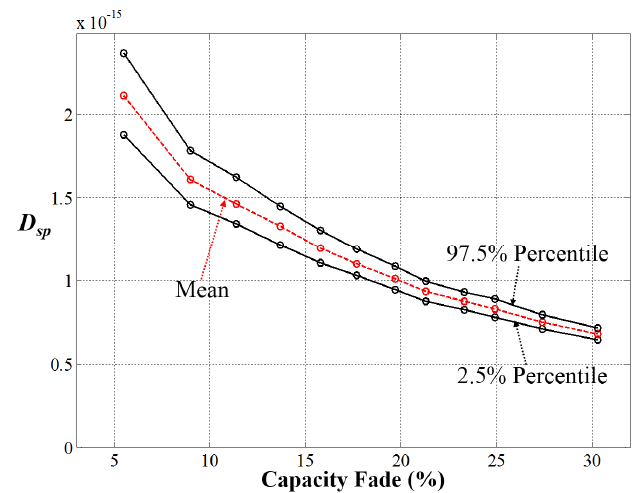
Figure 9. Parameter ( D sp ) estimate using metamodel (see Figure